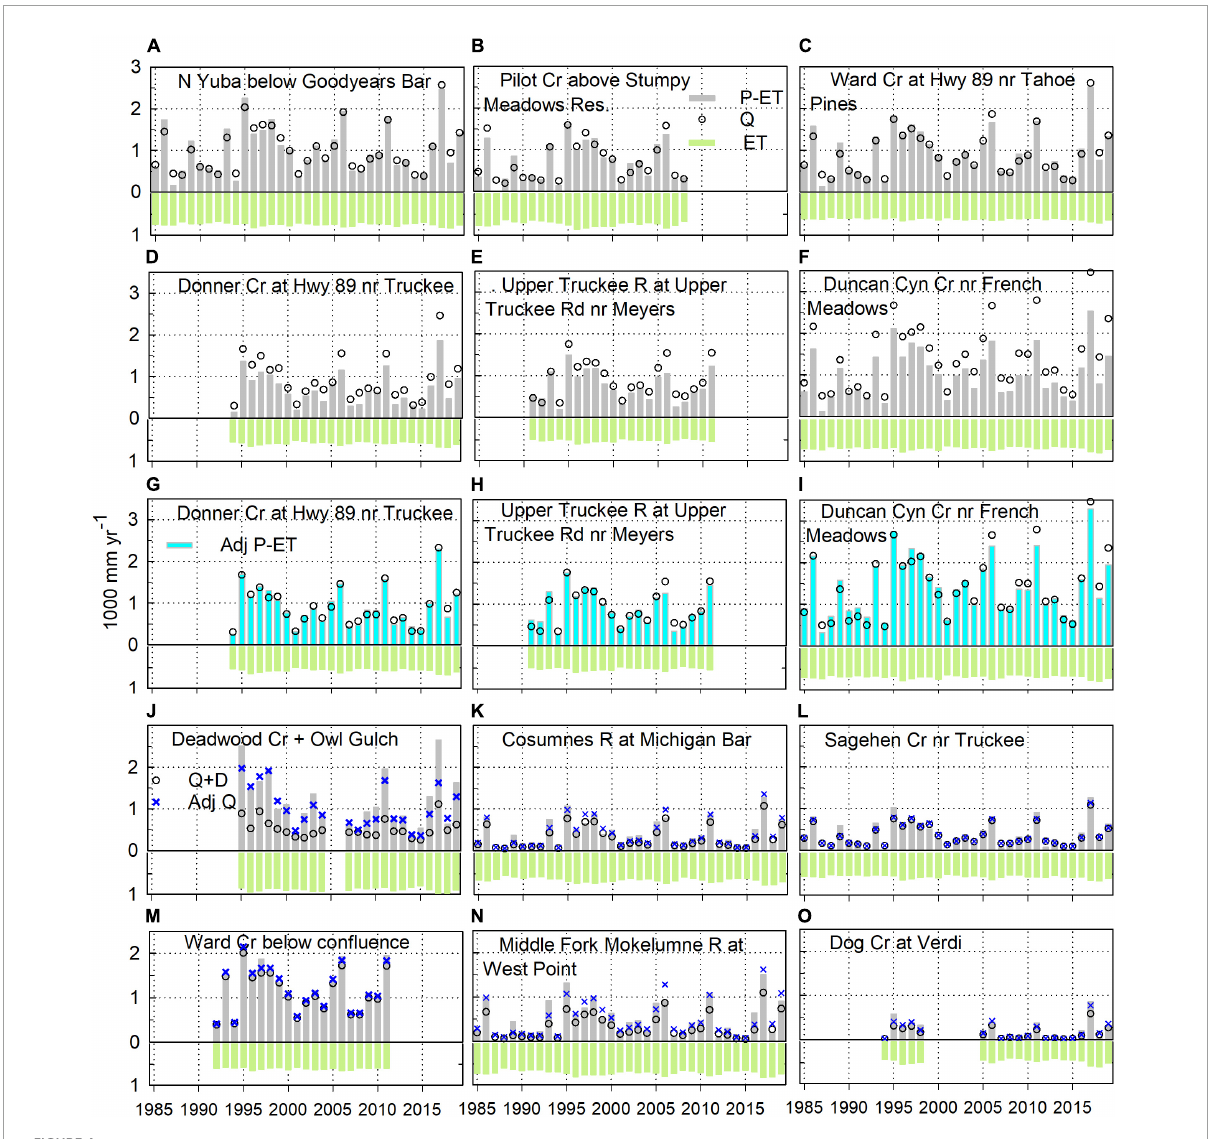
FIGURE4 Water-balance time series for watersheds shown in Figure 3 (A–F) and Figure 5 (G–O) . Note figure legends in (B,G,J)